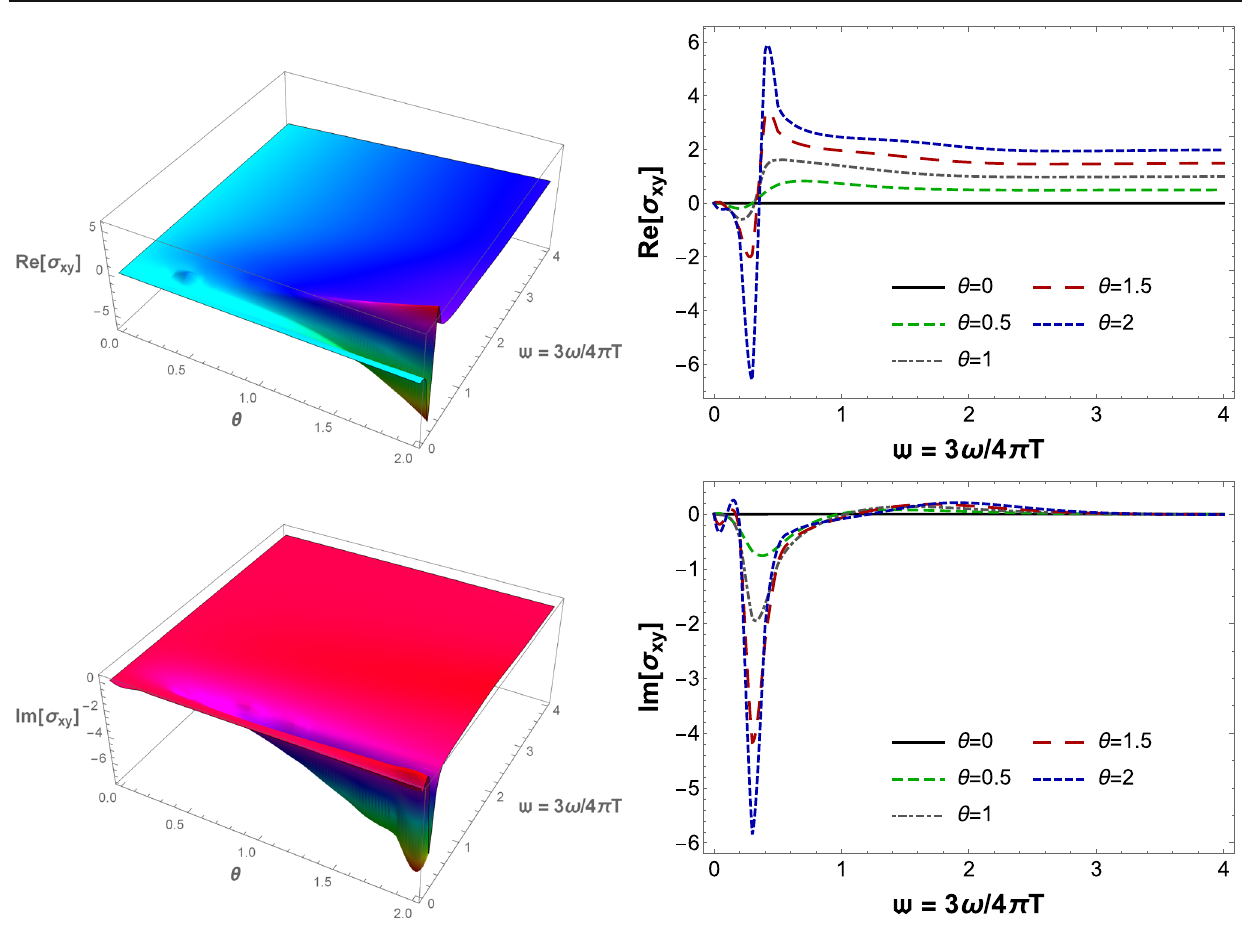
ing the characteristic mass scale (cid:12) of the bulk monopole